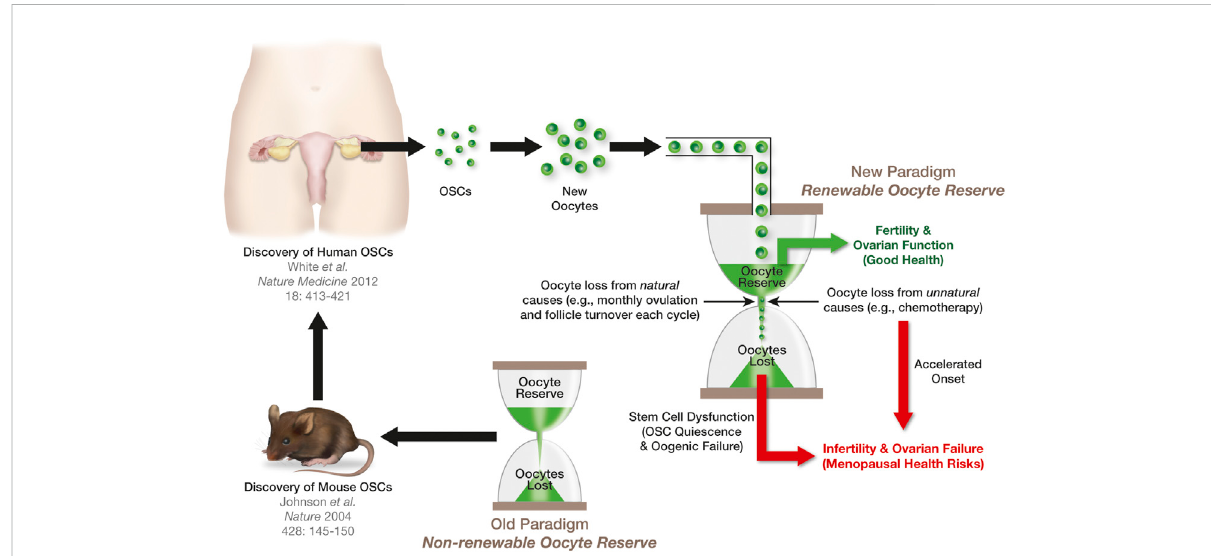
FIGURE 3 Signi fi cance ofOSCstoovarian agingandthemenopause.Thefemalebiologicalclockcanbeviewedinthesamemanneras anhourglass,with eachgrainofsandintheupperreservoirrepresentingasingleoocyteintheovaries.Thelossofoocytesfromthisreservenaturallythroughatresia,or unnaturallyfromexposuretoinsultssuchaschemotherapy,isdepictedasgrainsofsandrunningfromtheupperreservoirtothelowerreservoir.The ovarieswillfunctionuntilsuchatimethattheupperreservoirhasrunoutofsand.ThediscoveryofOSCsinmouseovaries(Johnsonetal.,2004) contradicted the long-standing paradigm that females are born with a nonrenewable oocyte population. The extension of this work to humans (White et al., 2012) raised the prospects that, in women, the upper reservoir of their biological clock is routinely replenished through stem cell- supported de novo oogenesis during adult life to sustain ovarian function (see also Alberico et al., 2022). However, the progressive quiescence of OSCs with age shuts down oocyte production, eventually leading to exhaustion of the oocyte reserve, ovarian failure, and the